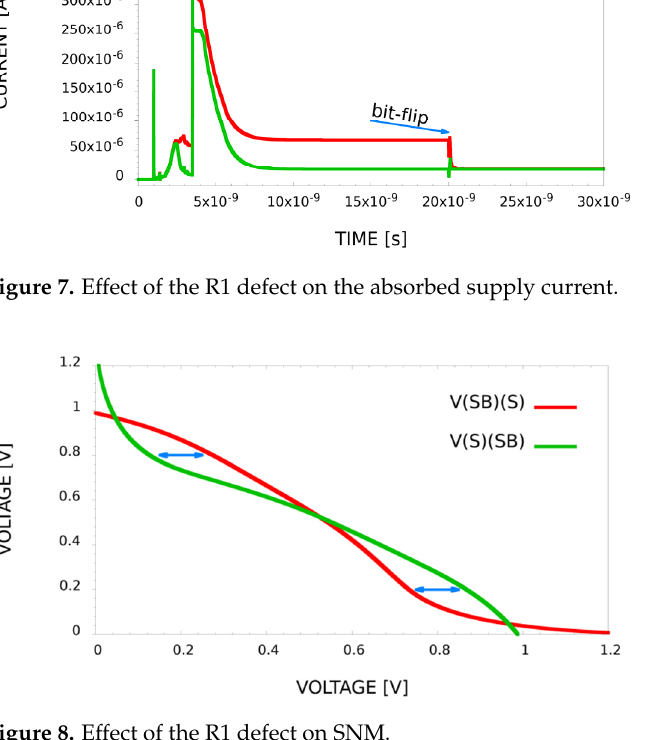
Figure 7. Effect of the R1 defect on the absorbed supply current.